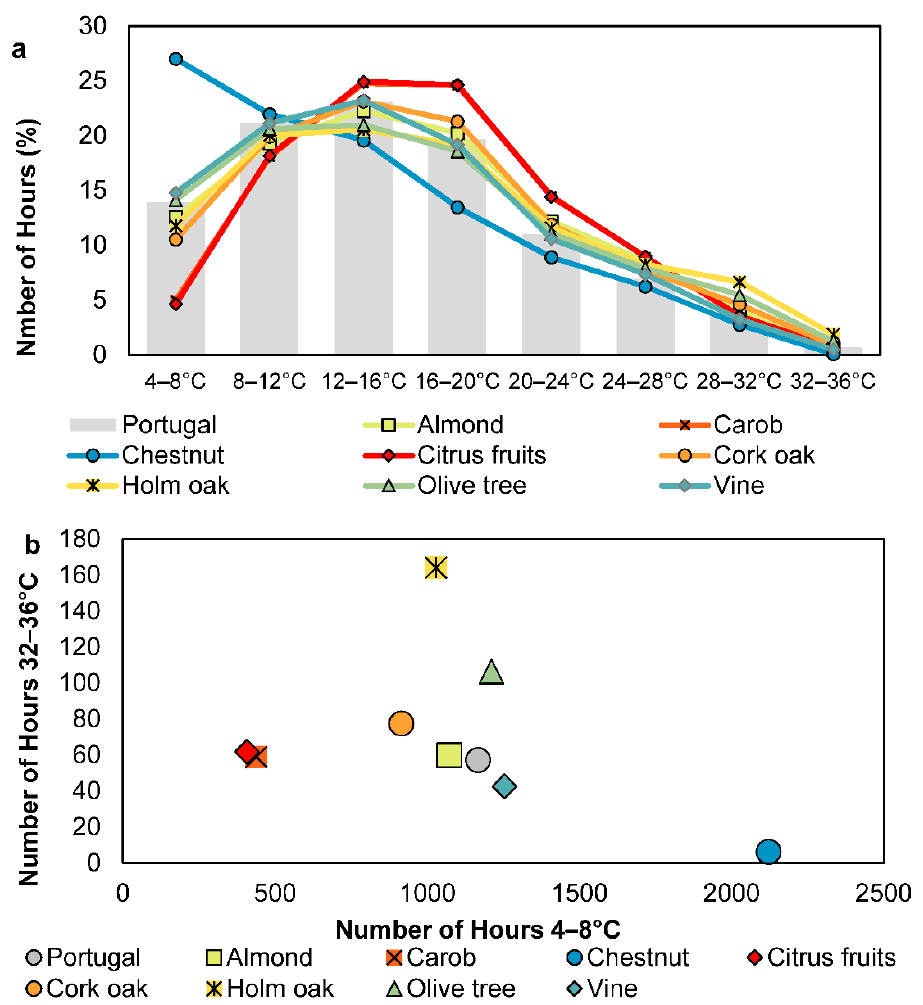
Figure 7. ( a ) Mean of the relative number of hours (in %) by the different temperature intervals, for the period of 2000–2018 and over mainland Portugal, for the eight selected fruit species. ( b ) Scatterplot for eight fruit species as a function of their corresponding means of the number of hours with temperature between 4–8 °C and the number of hours with temperature between 32–36 °C, over mainland Portugal and for years 2000–2018.